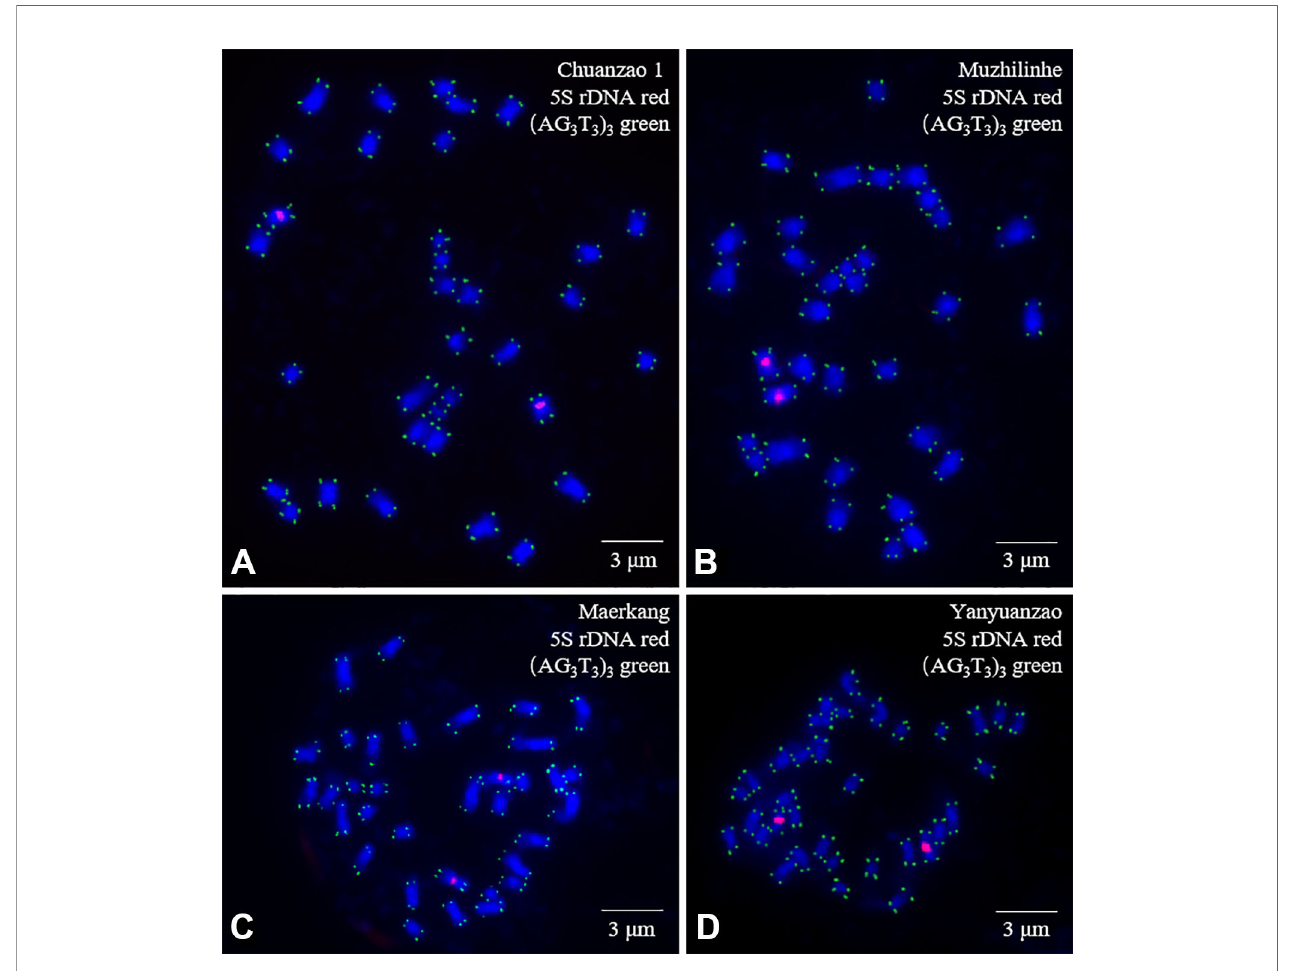
FIGURE 3 | Mitotic metaphase chromosomes of four walnut cultivars: (A) Chuanzao 1, (B) Muzhilinhe, (C) Maerkang, and (D) Yanyuanzao. Red represents 5S rDNA, while green represents (AG 3 T 3 ) 3 . The blue chromosomes were counterstained by DAPI. Scale bar = 3 m